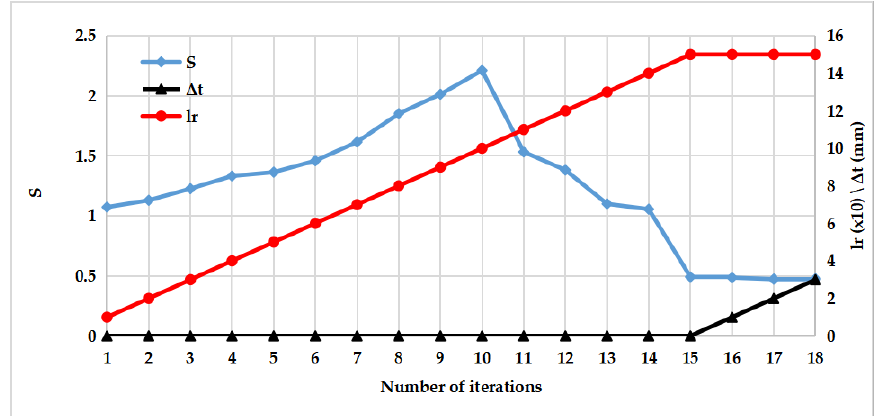
Figure 24. Iteration process of the optimization algorithm used in a DD coupler.